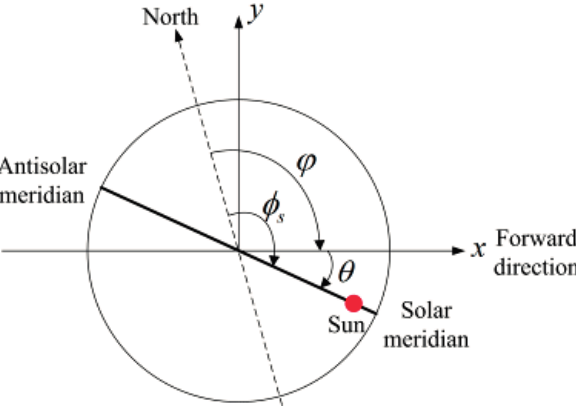
Figure 2. The relationship between the azimuth of the sun, the solar meridian orientation, and the vehicle heading in the horizontal plane.